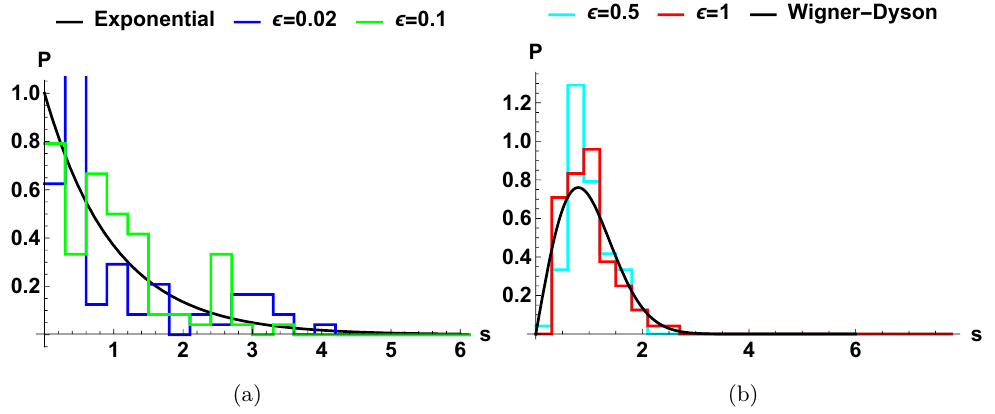
Figure 21 . Level spacing for free SYK with an chaotic cubic perturbation (6.9) (a) when the coupling (cid:15) is small and (b) when the coupling is large. As the chaotic term becomes comparable in magnitude to the free term, the level spacing statistics shift from exponential to